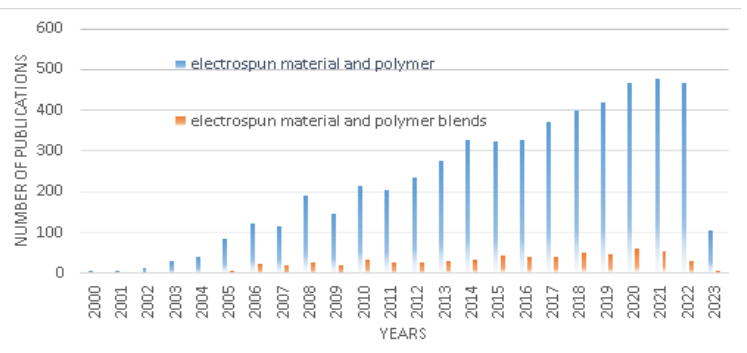
Figure 7. Scopus database number of publications over years comparison for the word “electrospun materials” and “polymer” (blue) to “electrospun materials” and “polymer blends” (brown).